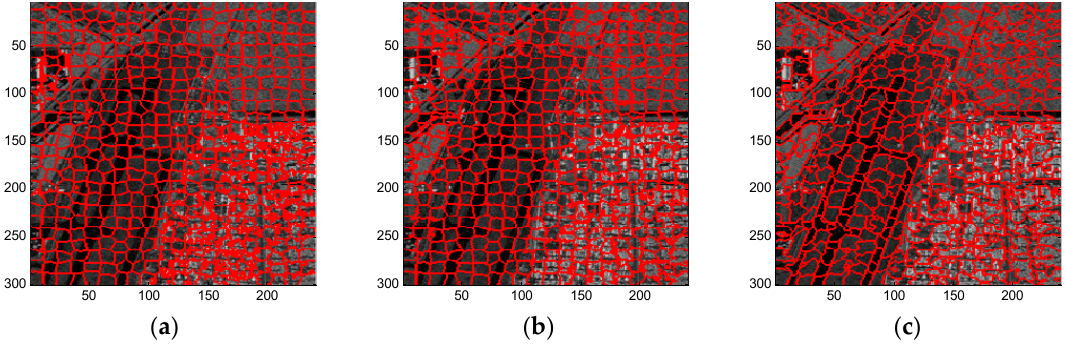
Figure 10. Superpixels of UAVSAR image provided by ( a ) standard SLIC; ( b ) compound method; and ( c ) proposed algorithm with regularization parameter w “ 0.6.